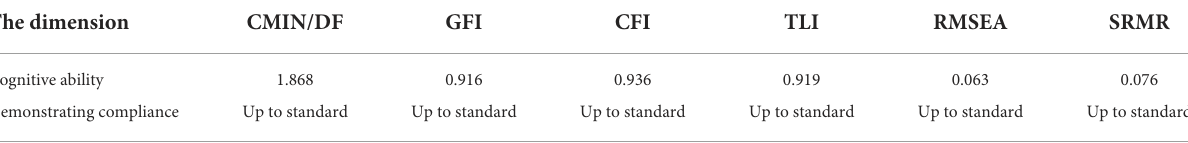
TABLE 3 Results of the overall model fitness test for confirmatory factor analysis.